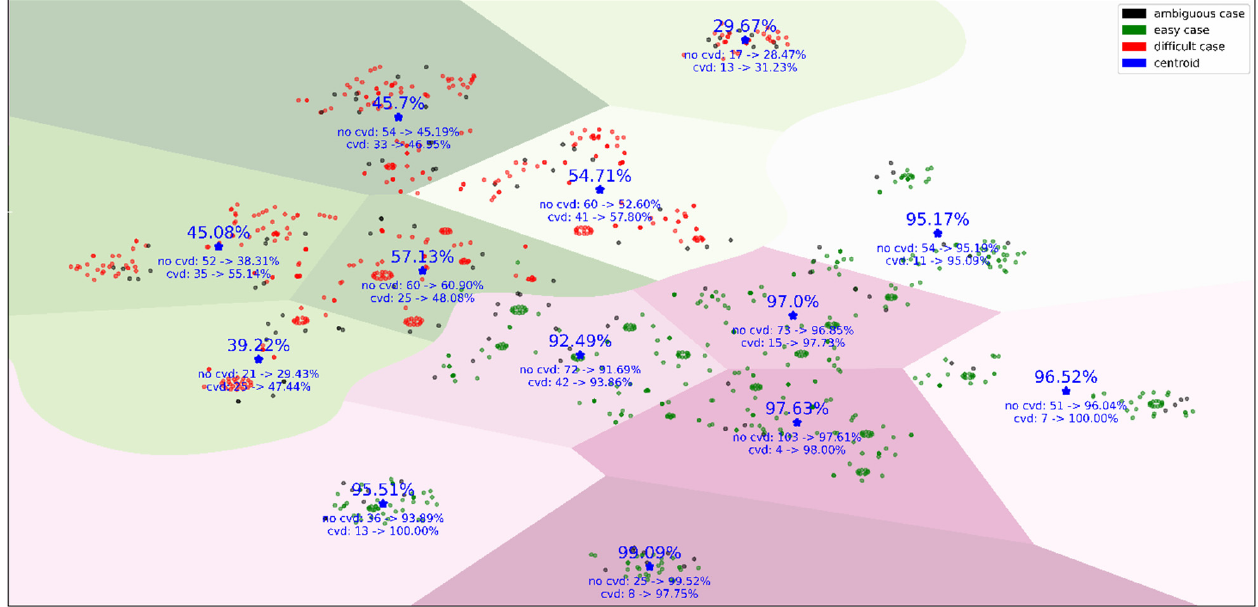
Figure 4. The KIHD subjects mapped from the 82-dimentional rule space onto the plane. This figure contains the subjects covered by the final set of rules. A separating line between “easy” and “difficult” cases was drawn by a support vector machine [30], and then borders between clusters were defined using the k-means method [31]. The overall model accuracy, true positive rate (TPR), and true negative rate (TNR) within clusters averaged over 50 independent runs of five-fold cross-validation, as well as the number of subjects who died by 2016 (“cvd”) and stayed alive by 2016 (“no cvd”), are given for each cluster.